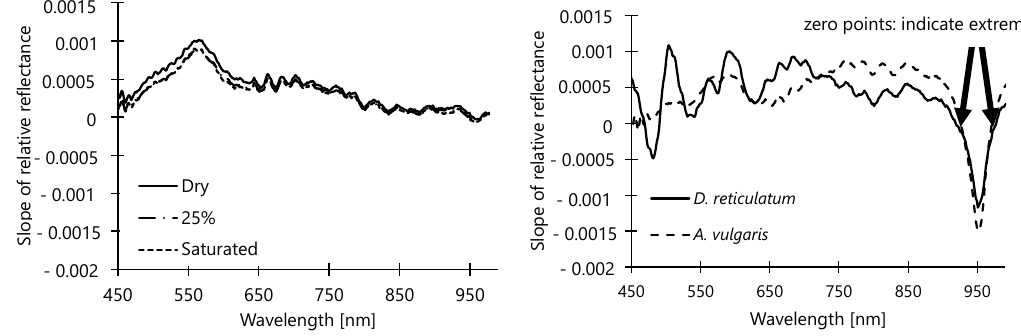
Figure 5. First derivative of the relative reflectance of soils ( left ) and slugs ( right ).